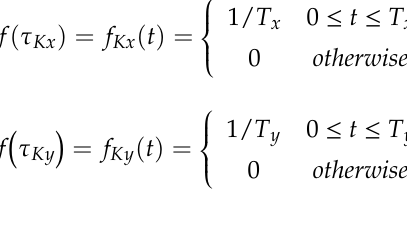
Figure 8. Random trip in a two-dimensional taxicab geometry (Manhattan distance) represented in the time